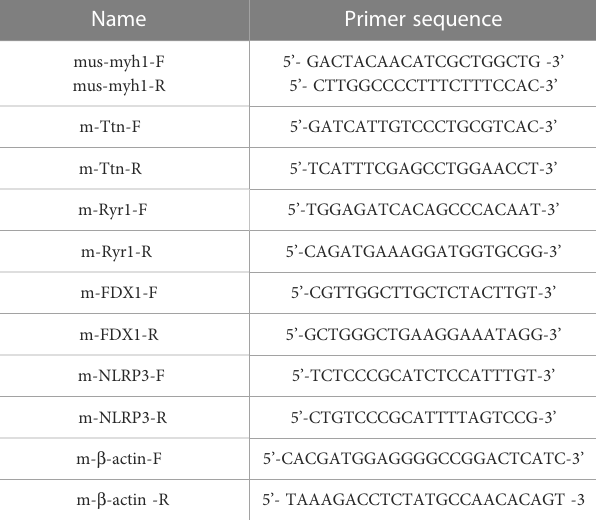
TABLE 1 Primer nucleotide sequences of